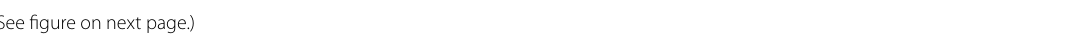
Using a seismic tomography with a spatial resolution of 2 km, Shibutani et al. (2005b) showed that the crustal structure along the mainshock fault of the 2000 West- ern Tottori Earthquake was characterized by high veloc- ity and suggested that a wide kilometer-order damage zone did not develop because the mainshock fault was an immature young active fault. These results suggest that numerous aftershocks occurred outside the fault damage zone.